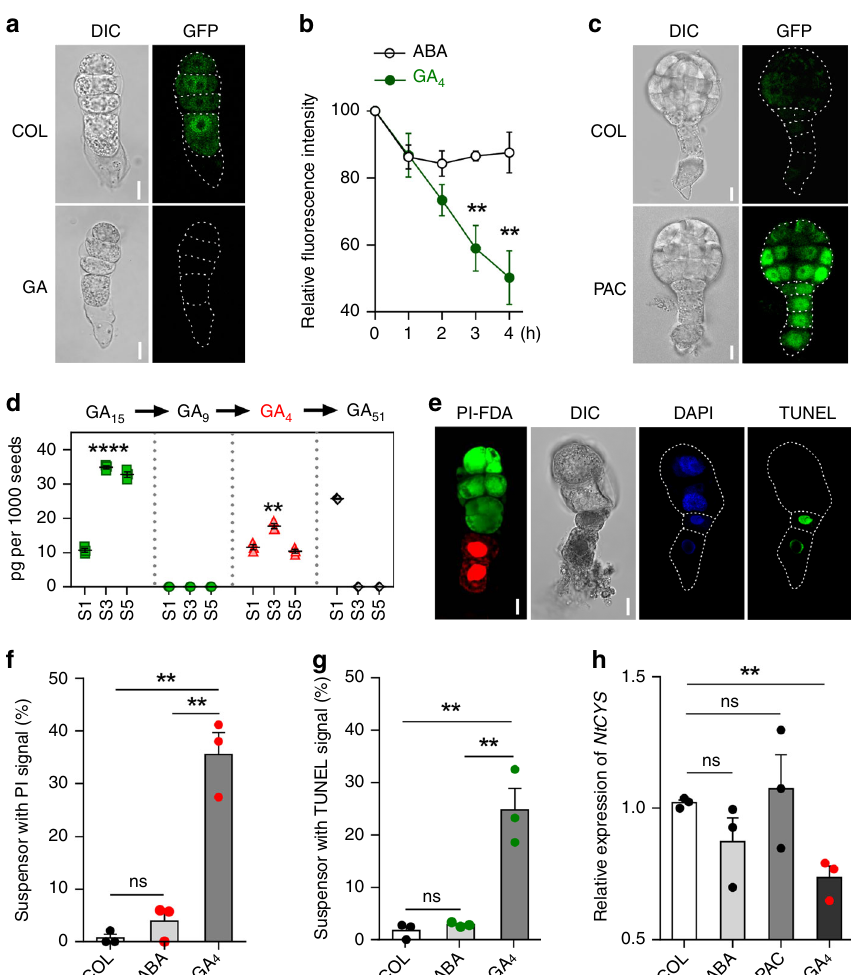
Fig. 3 GA induces suspensor PCD via the NtCRF1-NtCYS pathway in vitro. a NtCRF1-GFP fl uorescence in response to GA 4 in four-celled proembryos. 0.05% ethyl alcohol as control. b NtCRF1-GFP fl uorescence in the basal cells of two-celled proembryos during treatment with GA 4 (or ABA) ( n = 9). c NtCRF1-GFP in embryos derived from two-celled proembryo in cultured seeds after 72-h treatment with PAC. d Quanti fi cation of GA 15 , GA 9 , GA 4 , and GA 51 in WT seeds at stages 1, 3, and 5 (pg per 1000 seeds, ± SE). e Cultured embryos stained with fl uorescein diacetate (FDA), PI, and TUNEL. f Frequency of cultured embryos with PI-positive basal cells ( n = 128 – 152). g Frequency of treated cultured embryos with TUNEL-positive basal cells ( n = 106 – 126). h qRT-PCR analysis of NtCYS expression in 4-DAP seeds after treatment for 12-h with 100 μ M ABA, PAC, or GA 4 . Data are the means± SE of three independent experiments (Student ’ s t -test; ns, P > 0.05; ** P < 0.01; **** P < 0.0001). Scale bars: 10 μ m. The source data of the graphs are provided in